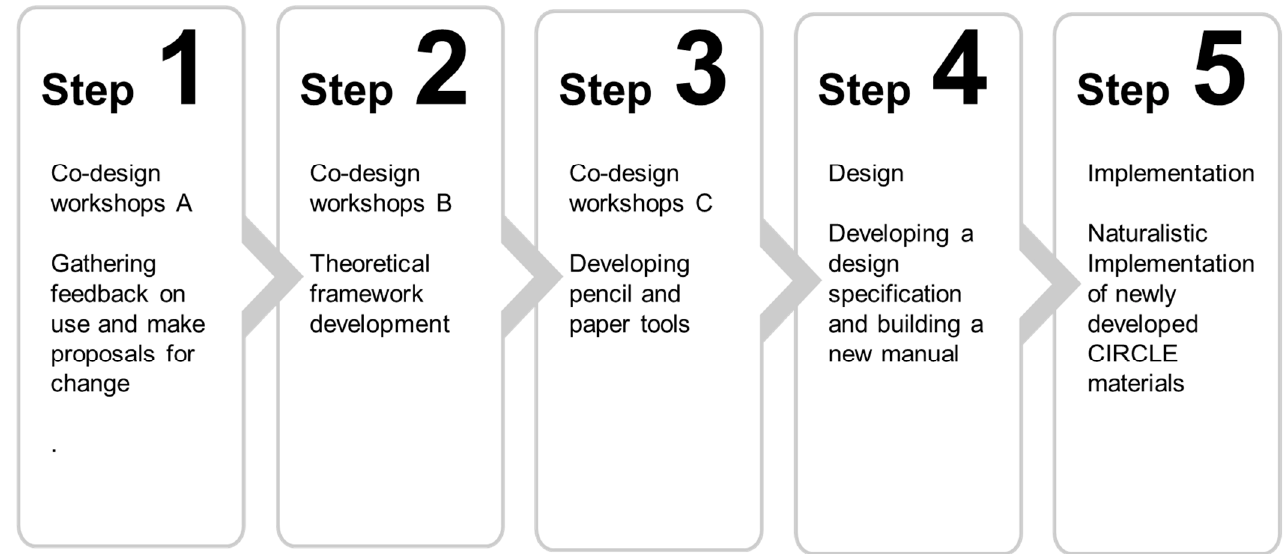
Figure 1. Process for development of CIRCLE framework.